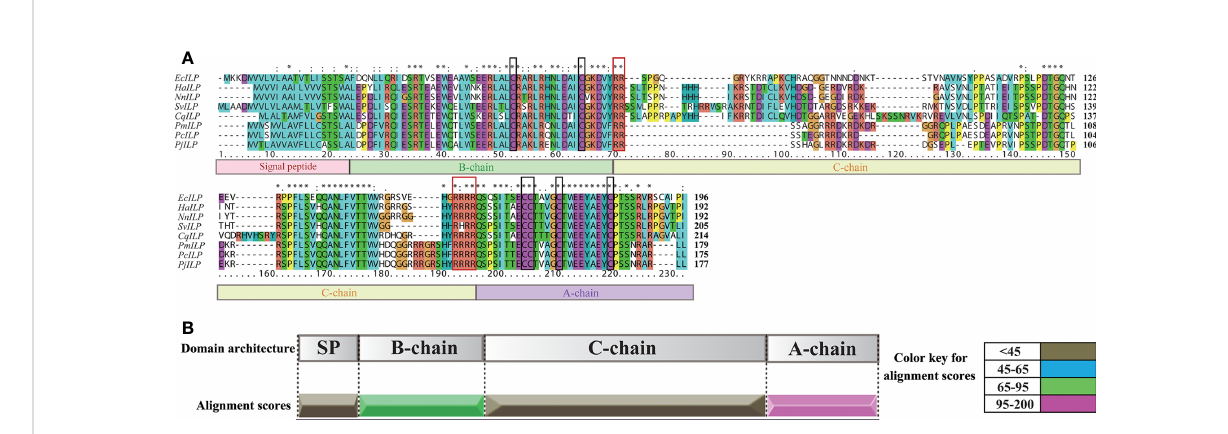
FIGURE 2 Multiple sequence alignment and sequence similarity scores of EcILP and other crustacean ILP proteins. (A) Multiple sequence alignment. Boxs under the sequences represent the signal peptide, B, C, A chains, respectively. Two cleavage sites and six conserved cysteine residues are shown in red and black boxes, respectively. The ILP sequence from Exopalaemon carinicauda (EcILP, in this paper), Homarus americanus (HaILP, XP_042233096.1), Nephrops norvegicus (NnILP, QBX89070.1), Sagmariasus verreauxi (SvILP, AIU40991.1), Cherax quadricarinatus (CvILP, AIU40992.1), Penaeus monodon (PmILP, XP_037788563.1), Penaeus chinensis (PcILP, XP_047482879.1) and Penaeus japonicus (PjILP, XP_042860749.1) were used for the alignment. Asterisks indicate fully conserved residues. (B) Sequence similarity score. Sequence similarity scores of different ILP chains are based on the multiple sequence alignment in (A)